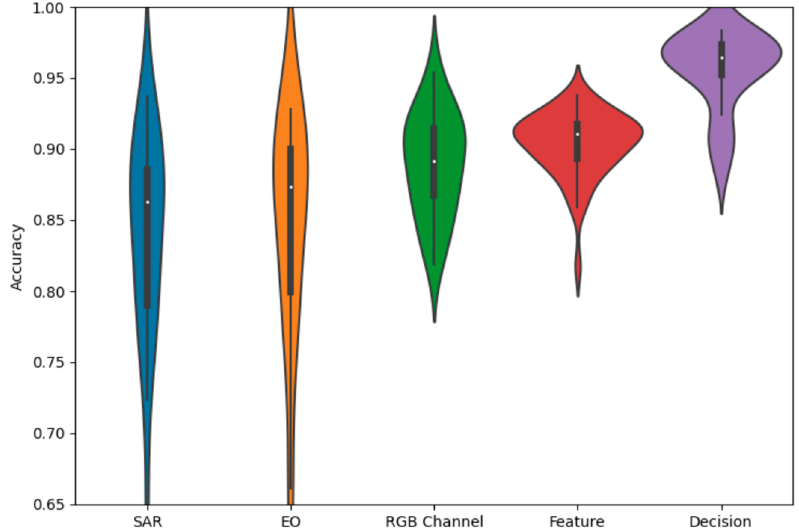
Figure 5. Accuracy distributions of fusion methods with ResNet18.